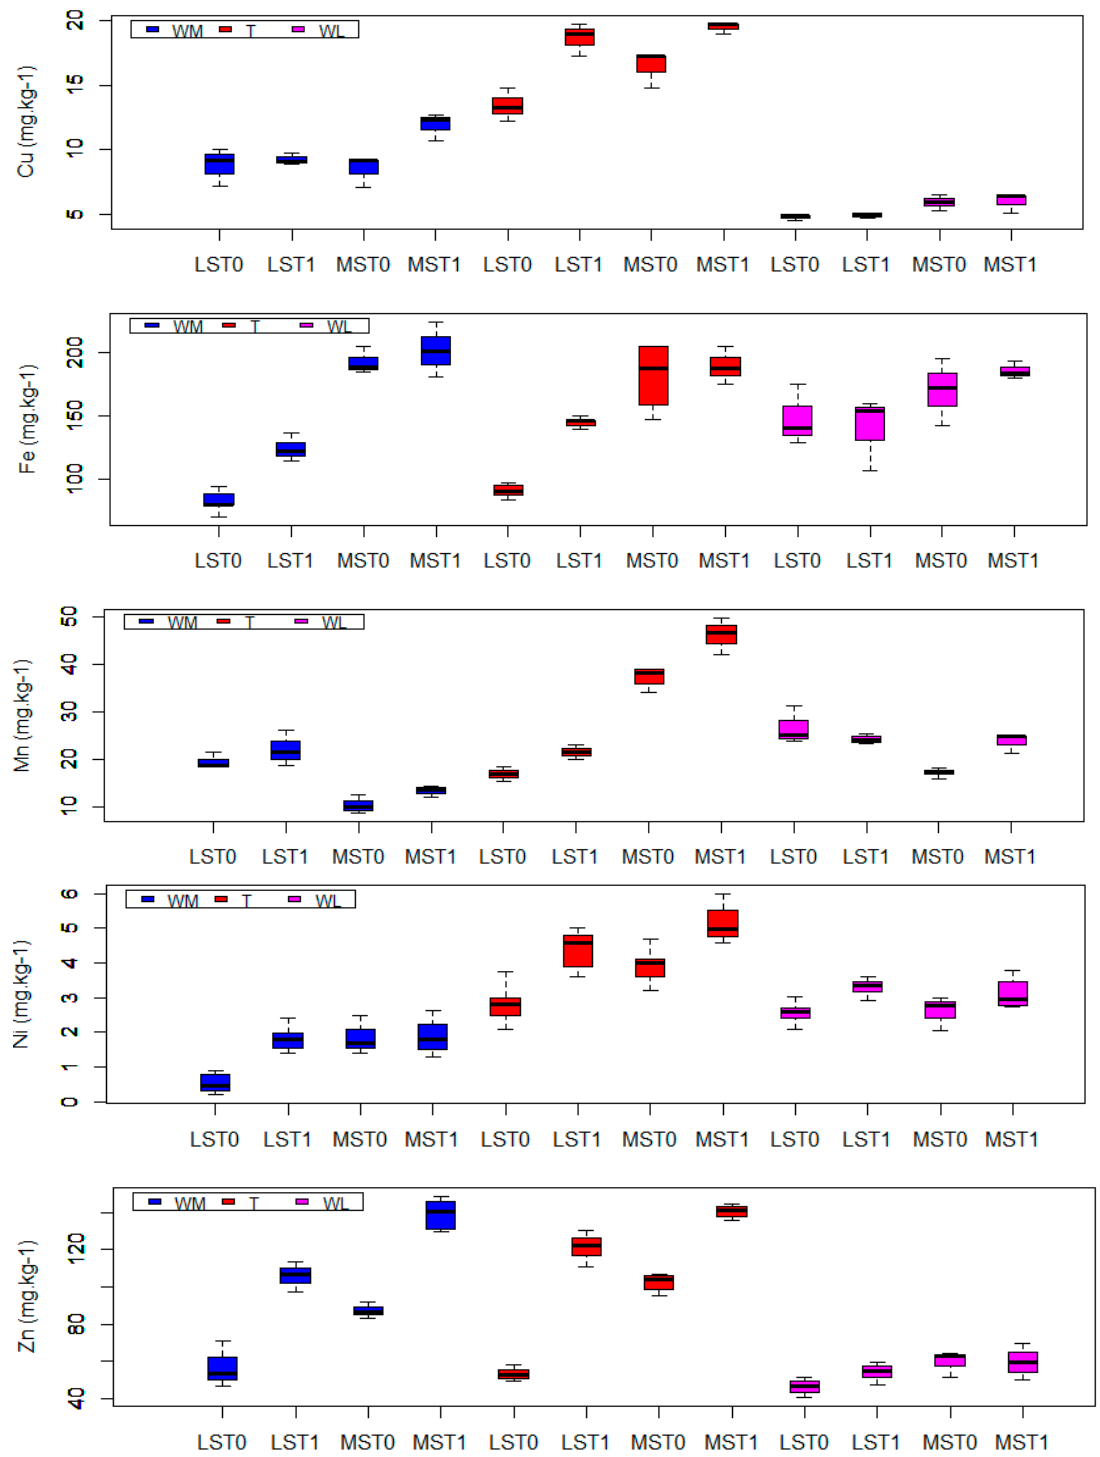
Figure 1. Content of microelements in shoots. In the figure, the minimal value, first quartile (Q1), median, third quartile (Q3), and the maximal value are given to display the distribution of data. On the OX axis, the combination of treatments are marked, for more details see description in Material and Methods.